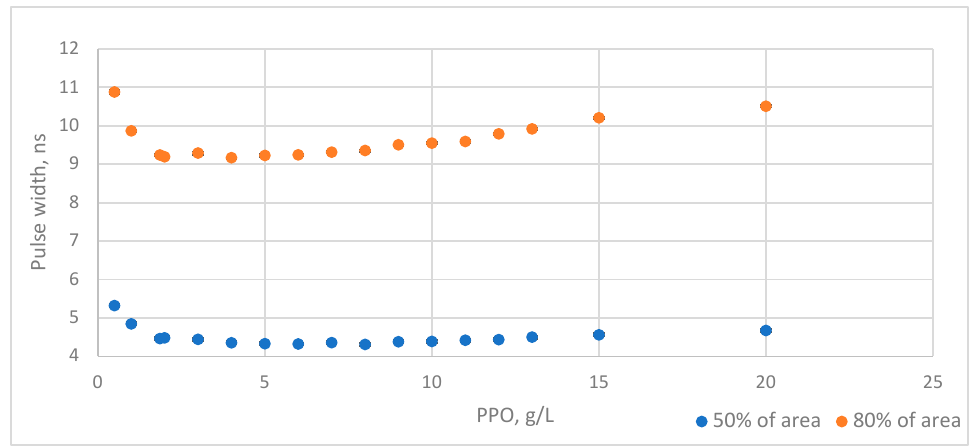
Figure 5. R580 PMT pulse width (50% and 80% of the total area) for different PPO concentrations. Error bars are ~0.1 ns and are not clearly visible.